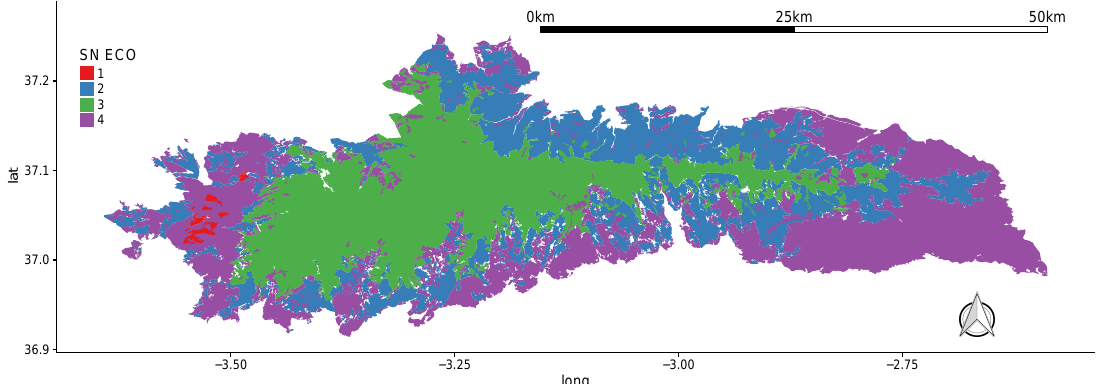
Figure 4. Map of predominant ecosystem types in Sierra Nevada National Park (abbreviated as SN ECO in the legend) spatially grouped to best match the resulting HFTs (source: [94]; European Petroleum Survey Group—EPSG:4326). Group legend: (1) natural pine tree forest; (2) oak tree forest and pine plantations; (3) high mountain shrubland, bare rock and scree; (4) agricultural areas, mid-mountain shrubland and